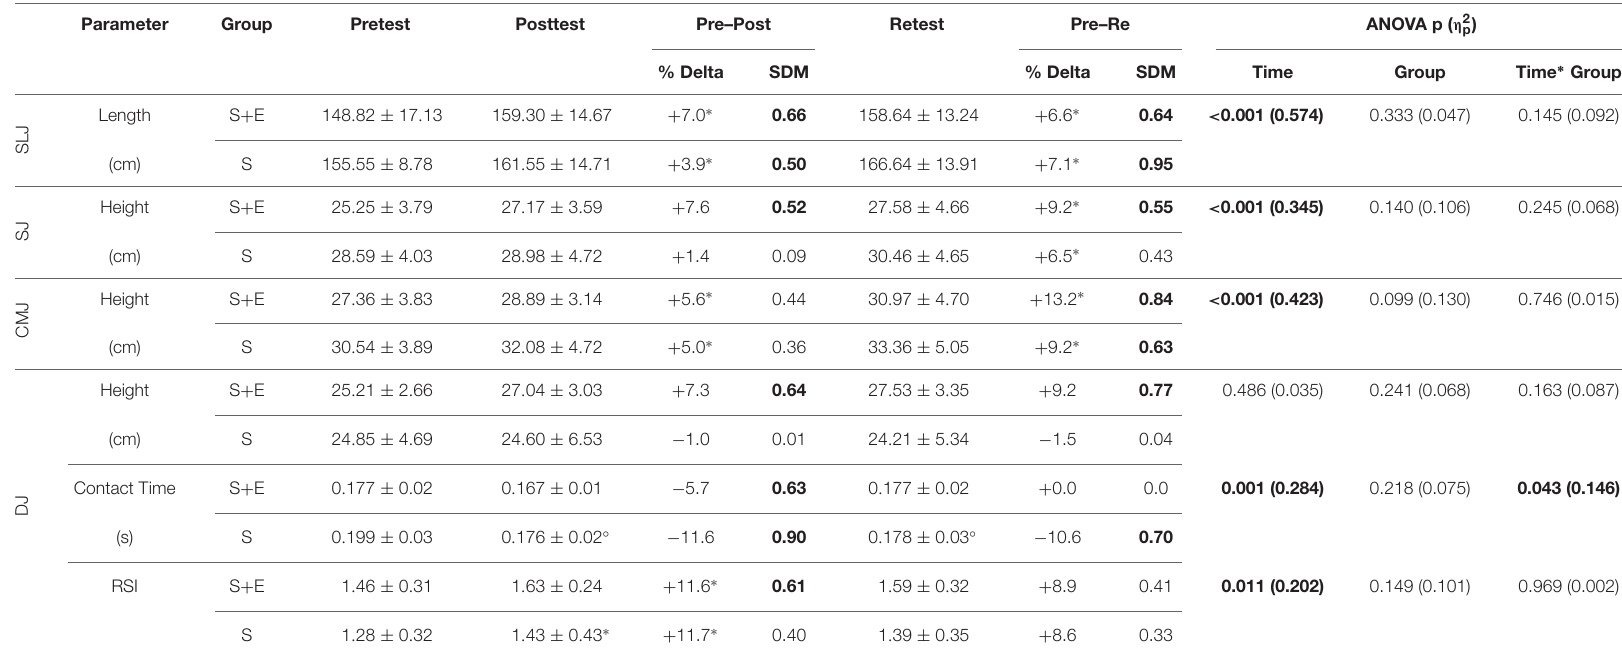
TABLE 5 | Changes in standing long jump (SLJ), squat jump (SJ) and counter movement jump (CMJ), as well as in drop jump (DJ) for length, height, contact time, and reactive strength index (RSI) in group S (strength training) and S + E (strength training with superimposed WB-EMS) during pre-, post-, and retests. Parameter Group Pretest Posttest Pre–Post Retest Pre–Re ANOVA p ( η 2 p )